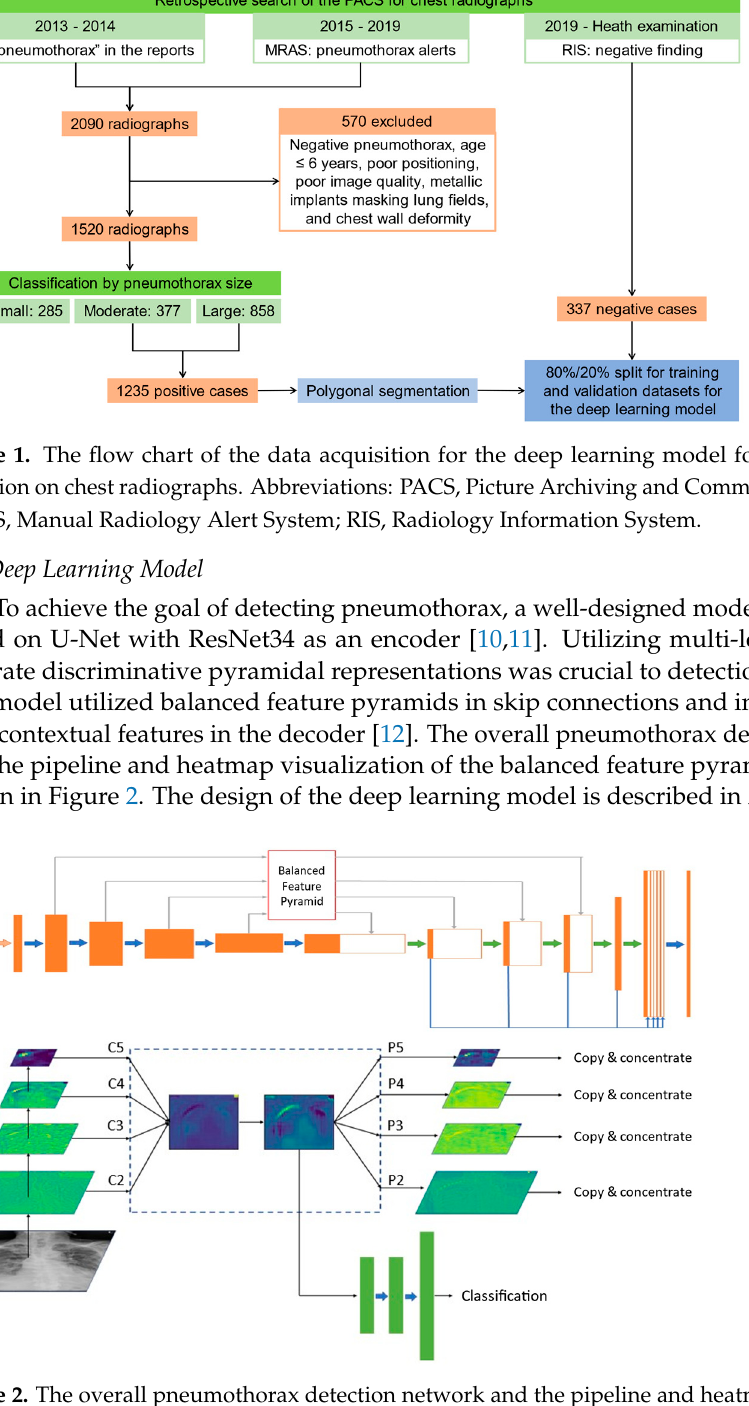
Figure 2. The overall pneumothorax detection network and the pipeline and heatmap visualization of the balanced feature pyramid module.